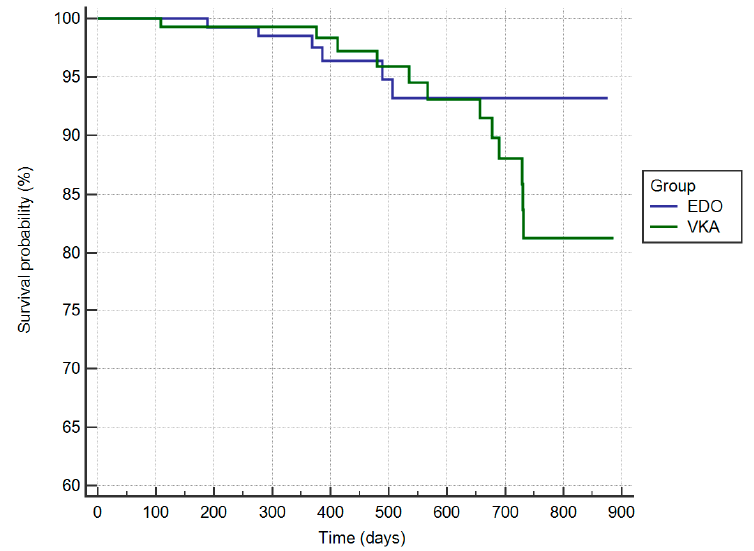
Figure 2. Kaplan-Meier cumulative probability of primary outcome event-free survival Edoxaban (EDO) and vitamin K antagonist (VKA) treatment group.